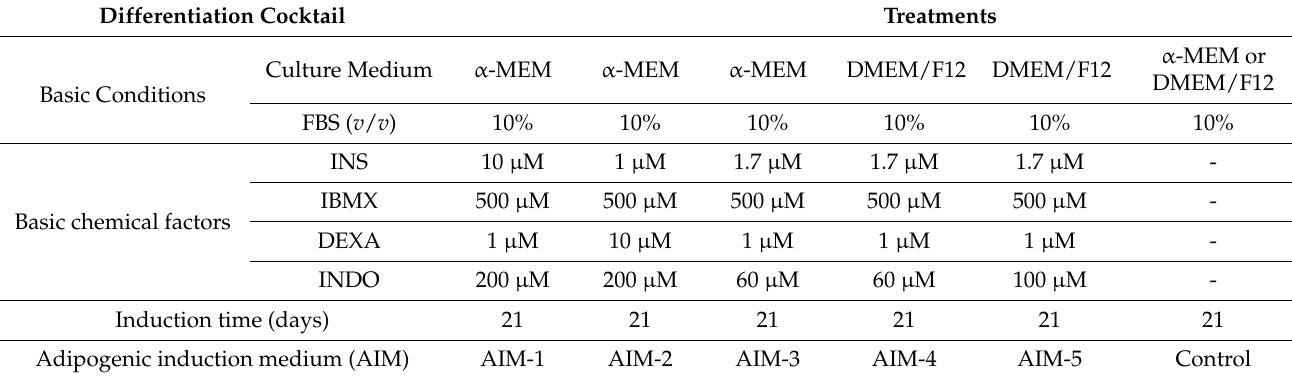
Table 1. Differentiation media for adipogenic induction of dental pulp stem